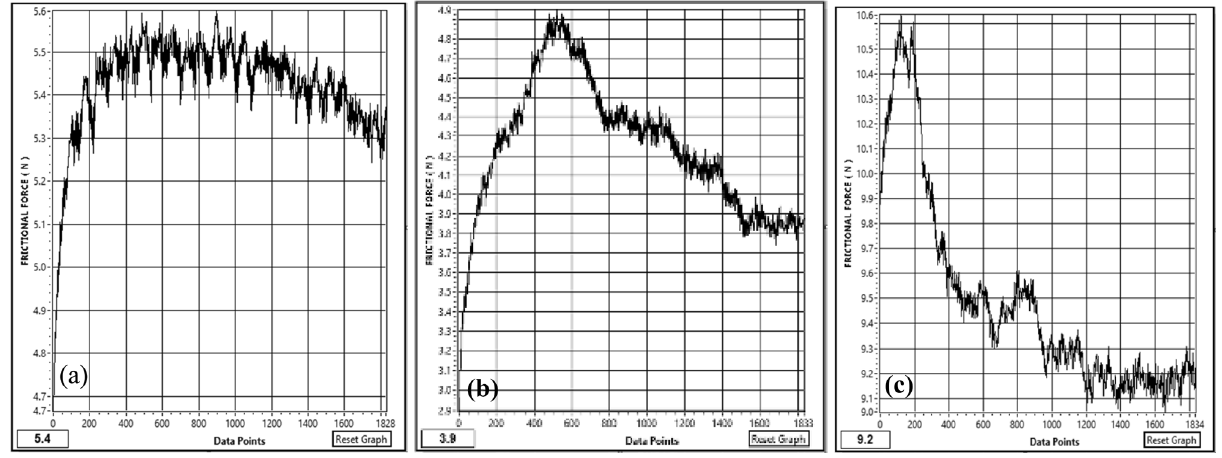
Figure 18. Friction Force of the specimens at data point ( a ) S1, ( b ) S2, ( c )